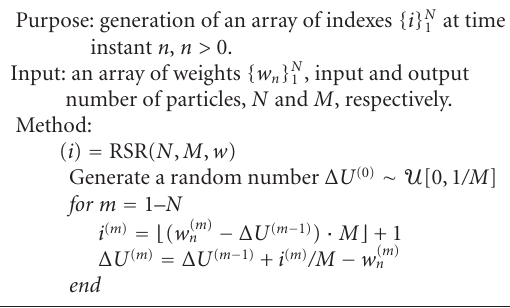
Algorithm 1: Residual systematic resampling